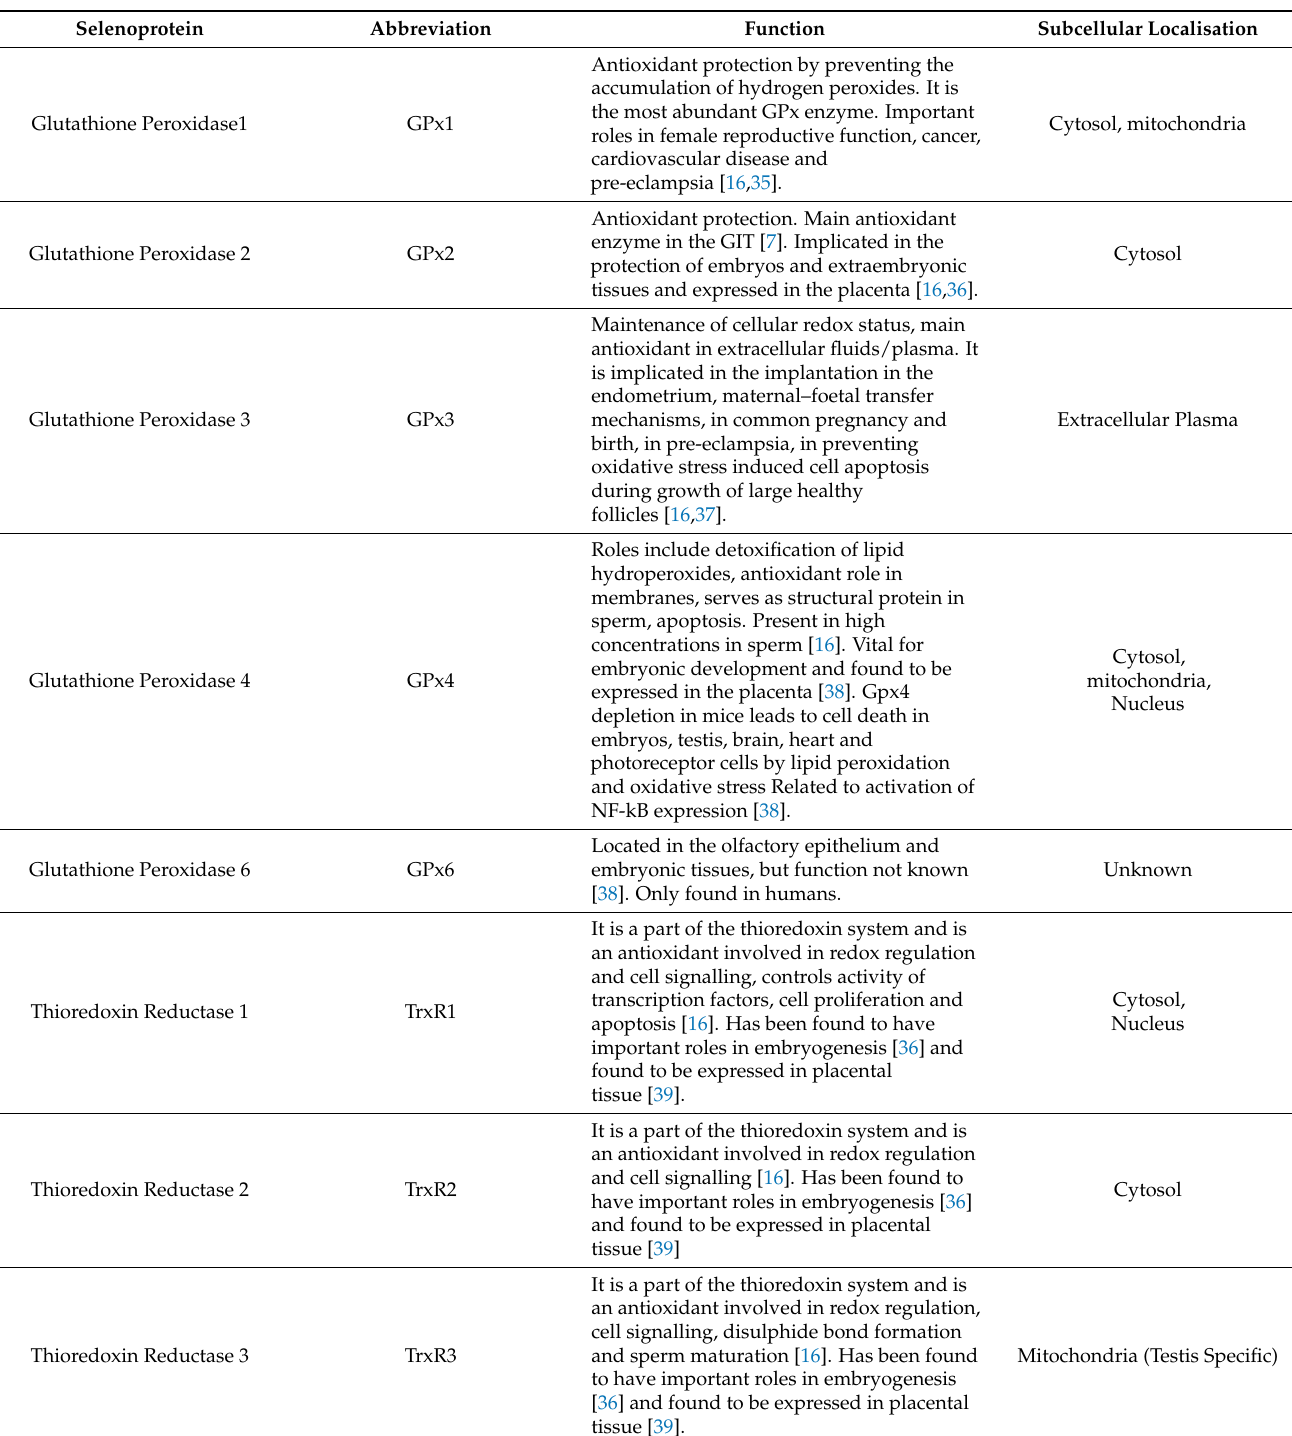
Table 1. Placental selenoproteins and their proposed